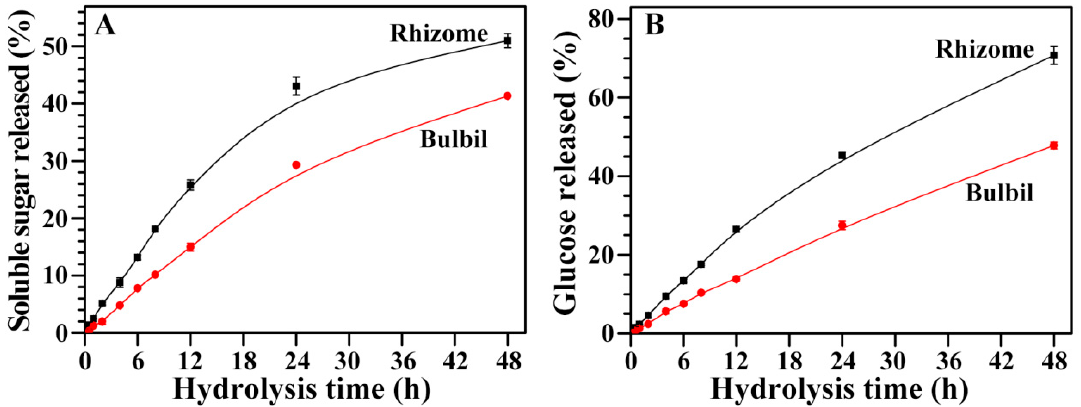
Figure 5. Hydrolysis curve by porcine pancreatic (PPA) ( A ) and in vitro digestion curve by both PPA and amyloglucosidase from Aspergillus niger (AAG) ( B ) of starches from the rhizome and the bulbil of Chinese yam.